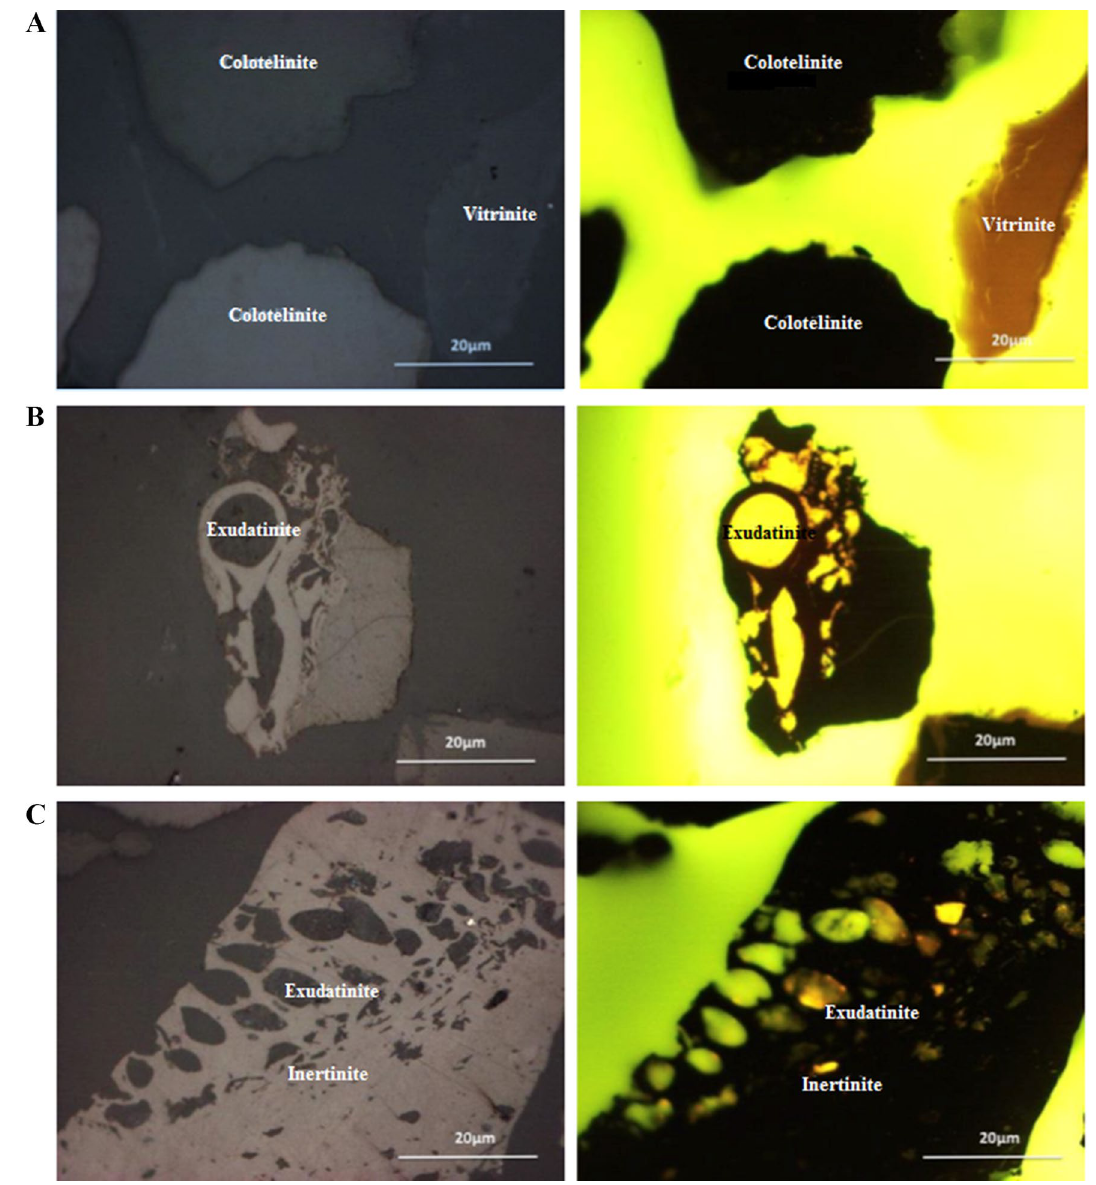
Fig. 7 Photomicrograph in reflected light and fluorescent (× 50) of sample T-11570. a Grains of vitrinite with different thermal maturities. b Inertinite and exudatinite, and c inertinite with